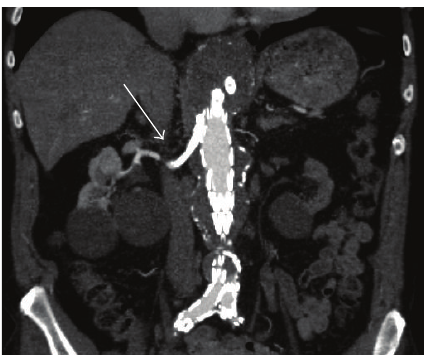
Figure 1: Postoperative CTA showing adequate position of the aortic branch graft with patent side branch in the right renal artery